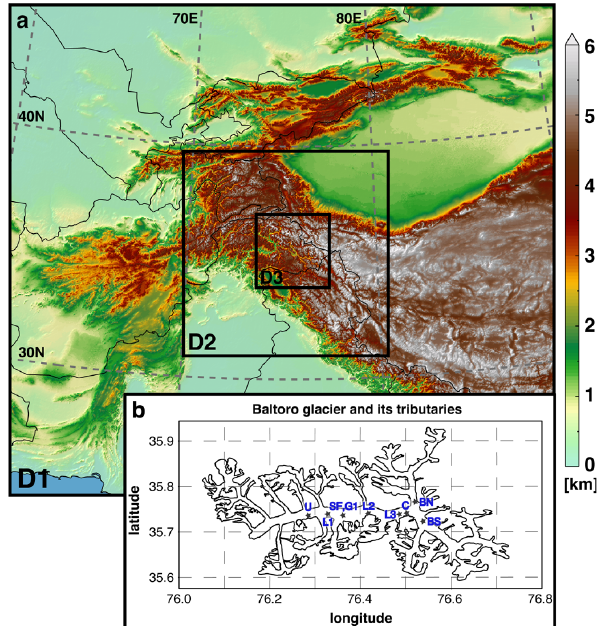
Fig. 1. (a) WRF atmospheric model domains, configured with hor- izontal spatial resolutions of 33, 11, and 2.2km. Terrain elevation from the GTOPO30 dataset is shaded in units of meters. (b) Outline of Baltoro glacier and its tributaries, which are included in WRF D3, with the mean stake locations labeled and denoted by